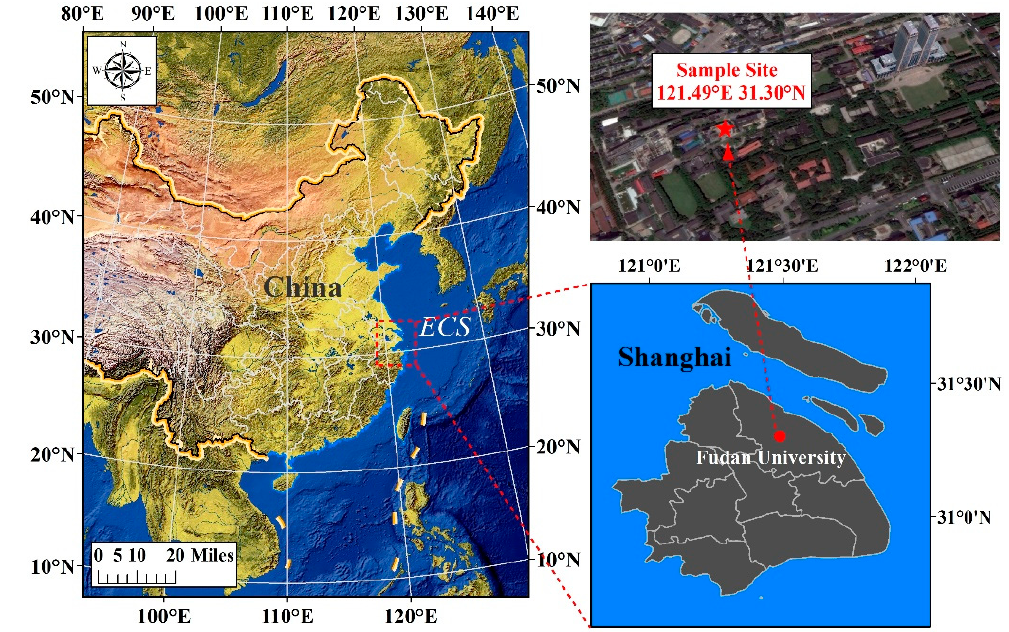
Figure 1. The location of the sampling site (marked with a red five-pointed star).